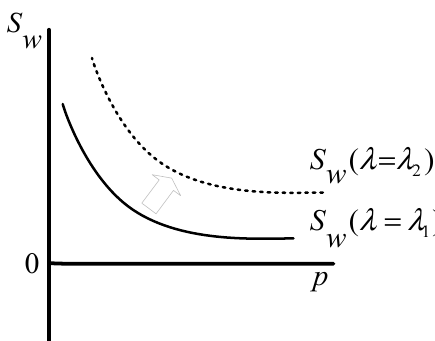
λ λ < λ on the social welfare ( 1 2 ).